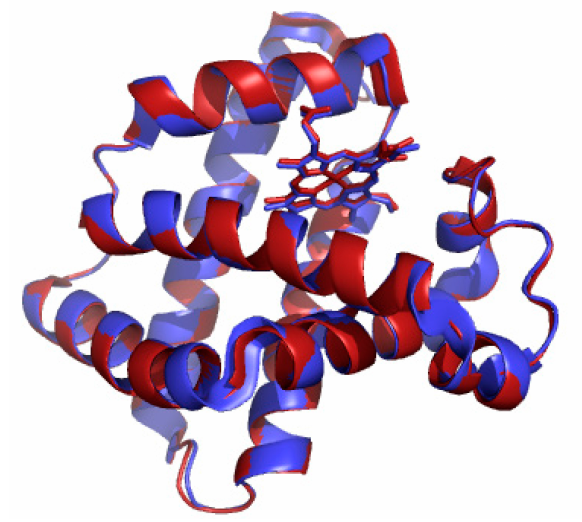
Figure 1. X-ray crystal structures of metmyoglobin (red, pdb accession number: 1YMB) [38] and manganese-substituted myoglobin (blue, pdb accession number: 2O58)